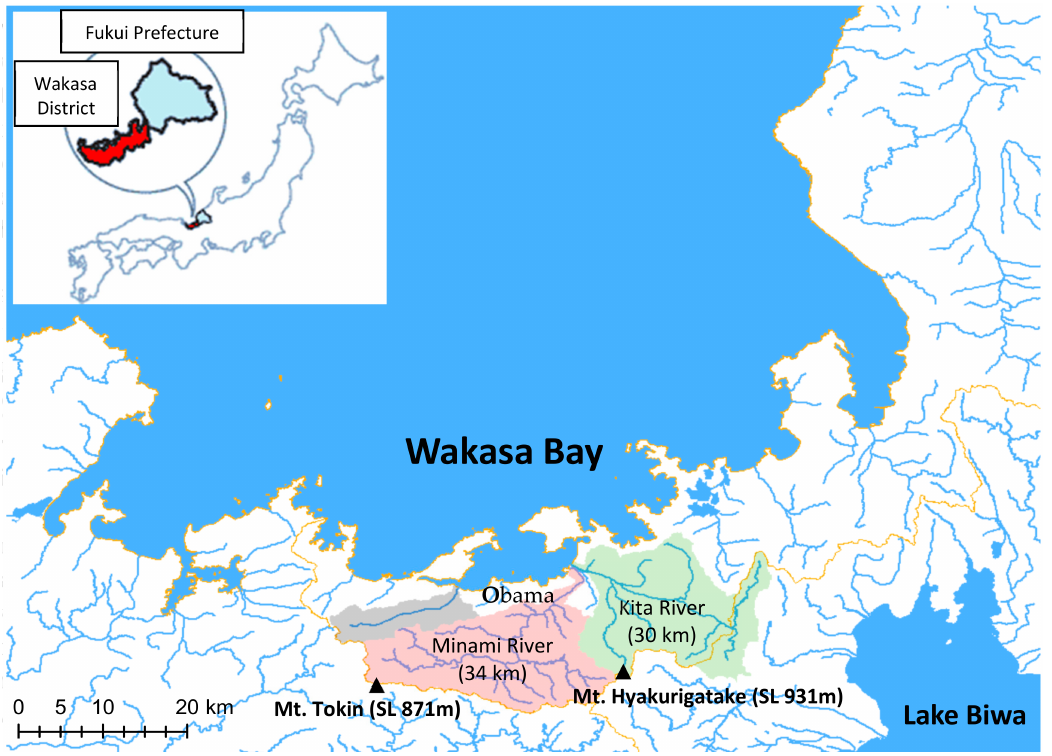
Figure 1. Map of the Wakasa District in Fukui Prefecture, including Obama City and the surrounding